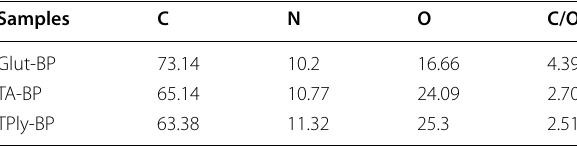
Table 1 Surface atom analysis determined by XPS spectra of three samples